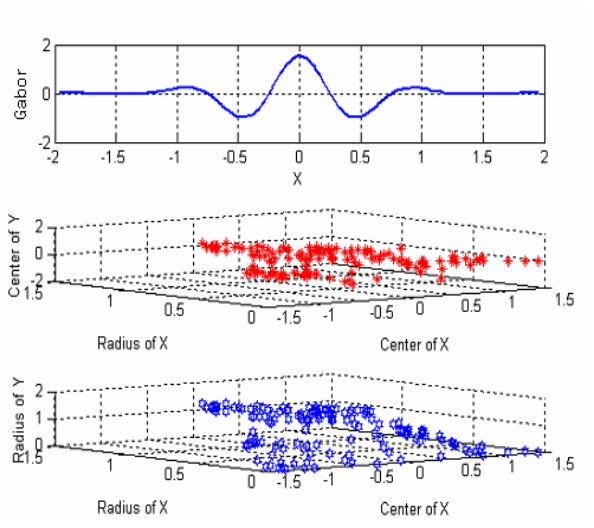
Fig. 3. This is Gabor function and generated sample data.